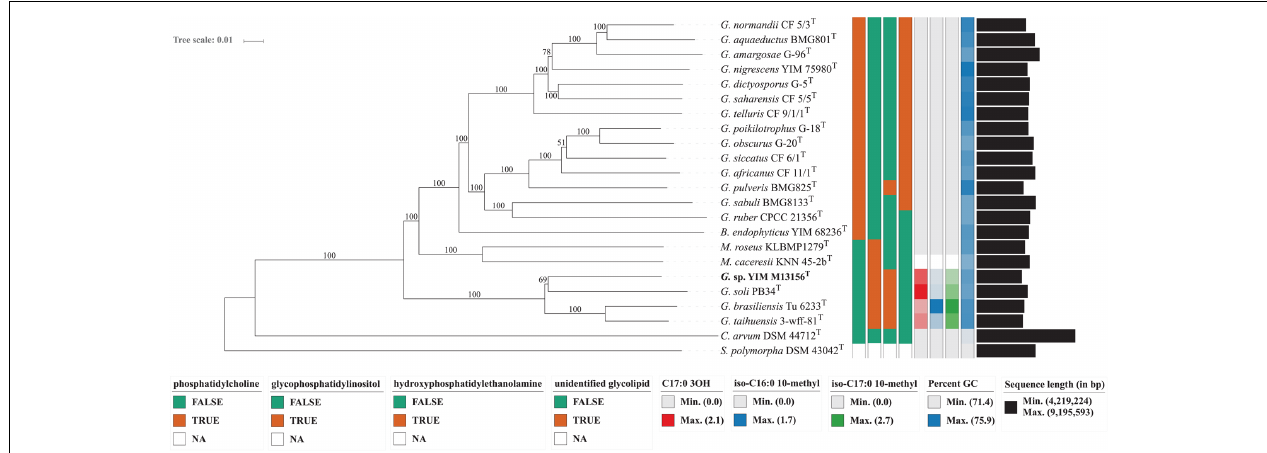
FIGURE 1 | Phylogenomic tree inferred with GBDP. The tree was inferred with FastME from GBDP distances calculated from whole proteomes. The numbers above branches are GBDP pseudo-bootstrap support values from 100 replications. Tip colors indicate chemotaxonomic characters that provide apomorphies for groups of interest, genome sizes and the exact G+C content as calculated from the genome sequences (see the embedded legend for details). B., Blastococcus ; C., Cryptosporangium; G., Geodermatophilus; M., Modestobacter; S., Sporichthya ; NA, not applicable.